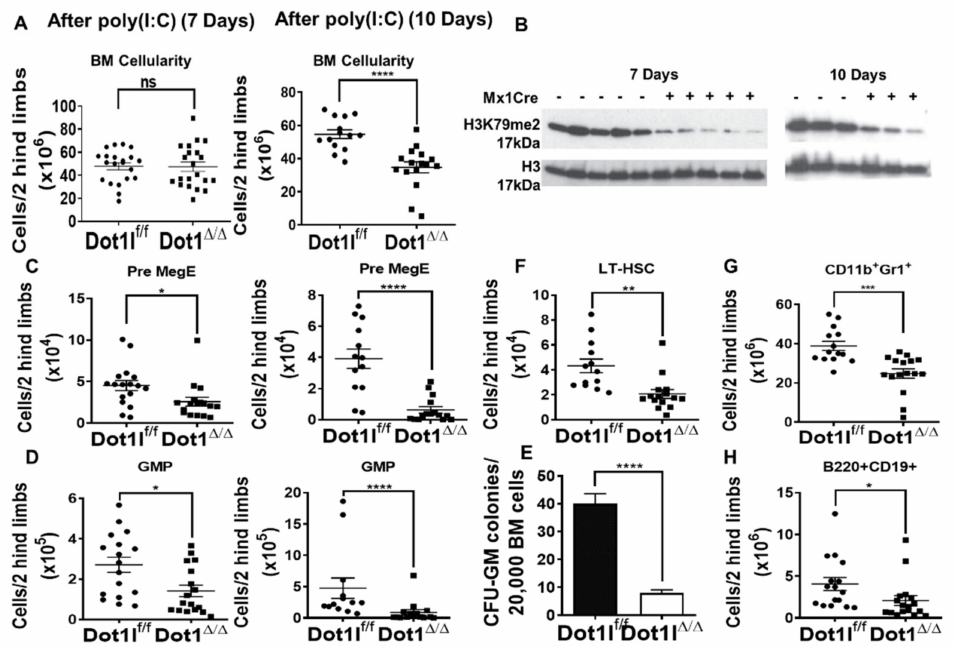
Figure 4. DOT1L inactivation in the adult bone marrow leads to rapid depletion of myeloid progenitors, followed by decrease in the numbers of hematopoietic stem cells ( A ) (left) Bone marrow cellularity in Dot1l f/f Mx-Cre- and Dot1l f/f Mx-Cre+ mice 7 days post poly(I:C) induction (n = 21 mice/group, pooled from 5 independent experiments; mean +/- SEM). (right) Bone marrow cellularity decreases in Dot1l f/f Mx-Cre+ mice 10 days post poly(I:C) induction. (n = 14–16 mice/group, pooled from 3 independent experiments; mean +/- SEM). ( B ) Western blot shows decreased H3K79me2 in total BM at day 7 (left) and day 10 (right); ( C ) Flow cytometric analysis quantification shows that Pre MegE progenitors (CD150 + CD105 - CD16/32 - CD41 - LK) are significantly decreased as early as day 7 (left) and continue to be depleted by day 10 (right). ( D ) Quantification of flow cytometric analysis showing that granulocyte-macrophage progenitors (GMP) (CD16/32 + CD150 - CD41 - LK) are significantly decreased as early as day 7 (left) and continue to decrease through day 10 (right). ( E ) Myeloid colony formation by wild-type vs Dot1l-null BM in CFU-GM assays (n = 8 mice/group with technical triplicates; mean +/- SEM; pooled from 2 experiments) showing a lack of colony formation potential in Dot1l ∆ / ∆ mice in comparison to Dot1l WT. ( F – H ) Profound decrease in LT-HSC, CD11b + Gr1 + BM myeloid cells, and B220 + CD19 + B cells at day 10 post poly (I:C). (ns p > 0.05, * p ≤ 0.05, ** p ≤ 0.01, *** p ≤ 0.001, **** p ≤